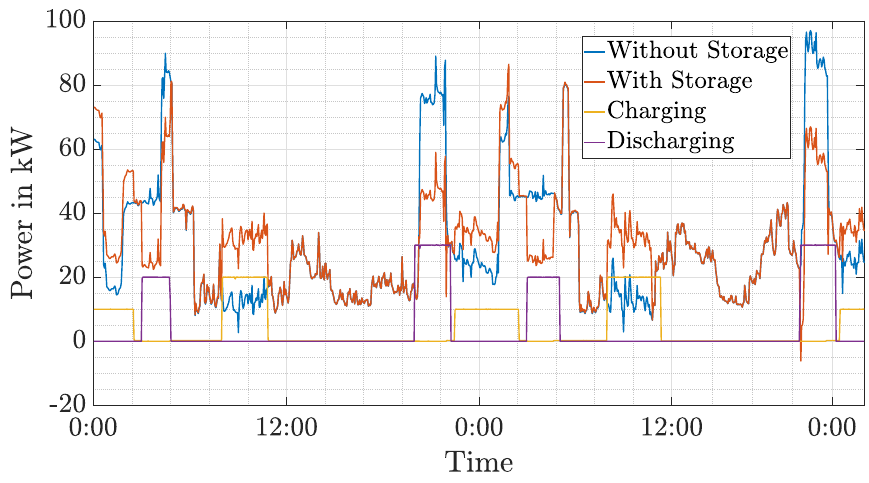
Figure 13. Results for the planned schedule for the fixed schedule strategy.